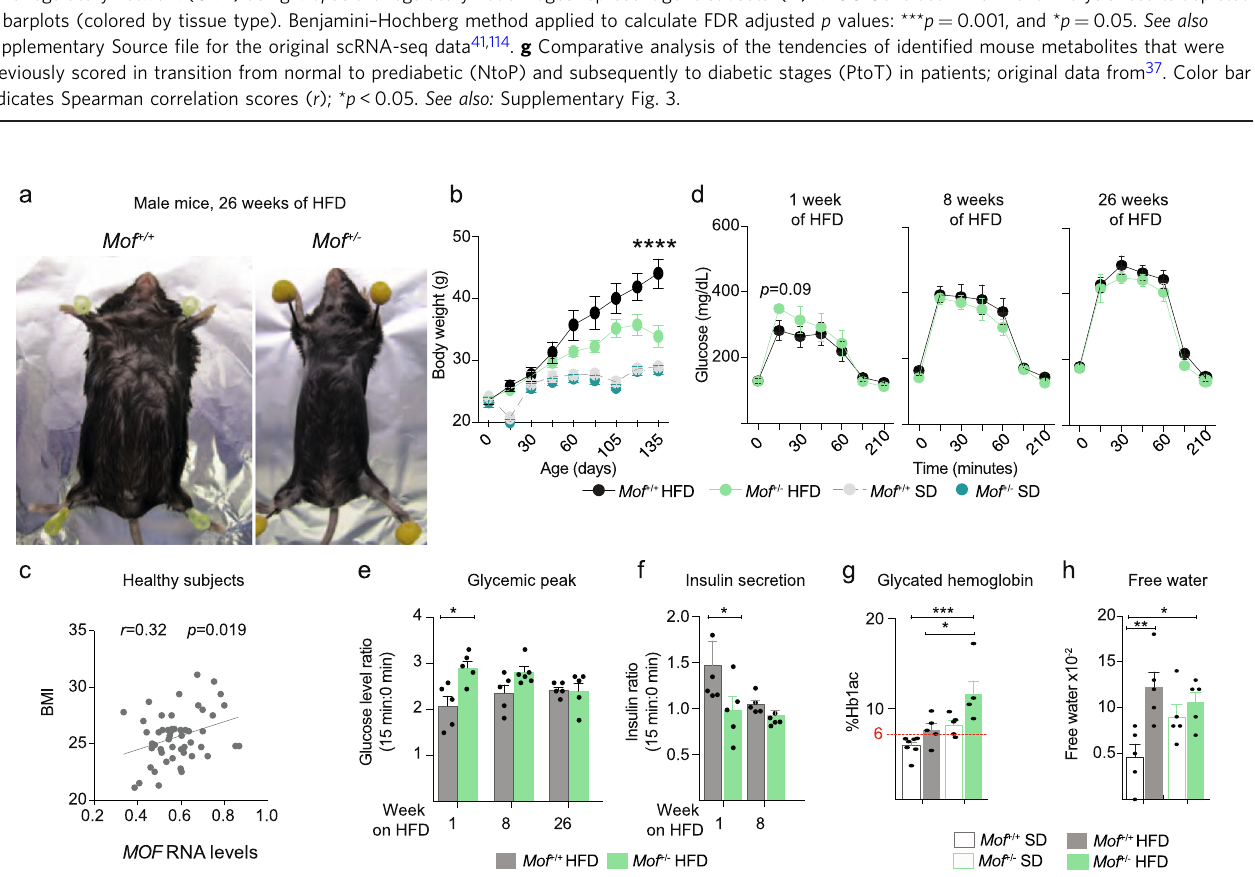
Fig. 2 Mof haploinsuf fi cient mice show impaired glucose tolerance and insulin secretion. a Barplots showing the total body weight (left), overall percentage of lean and fat mass, and total water of 8-week-old ( “ young ” , middle) or 26-week-old ( “ old ” , right) Mof + / + and Mof + / − animals under steady state (open bars) or after 16 h of starvation ( fi lled bars). Dots in the barplots represent independent animals and error bars represent ±SEM. n = 4 – 5/ group. b Blood glucose levels before and after oral glucose tolerance test (OGTT); 1 g/kg mouse; n = 5/group in 8- (young, left) and 26-week-old (old, right) n = 5/ Mof + / + and n = 4/ Mof + / − male mice. Statistical analysis performed by two side, two-way ANOVA. p values are indicated in the fi gure. Error bars represent means ± SEM. c Glycemic peaks are represented as a ratio of peak glucose level (15 min after oral administration) over steady-state (fasting) level. Statistical analysis performed by two-sided Mann – Whitney test, * p = 0.05. Error bars indicate ±SEM. n = 4 – 5/group. Serum insulin levels at ( d ) steady state (fasting) and ( e ) at maxima (15 min after oral glucose administration), represented relative to fasting levels. Statistical analysis performed